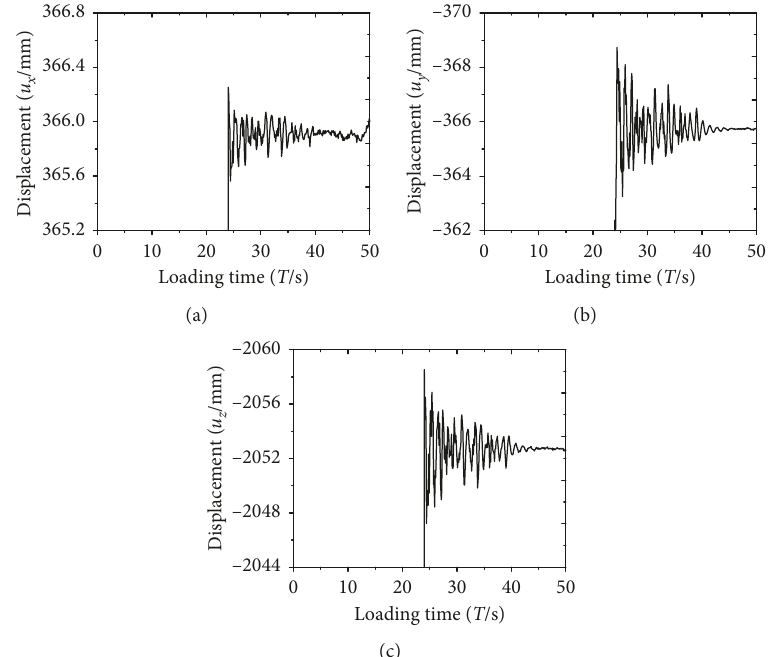
Figure 12: Variation of displacement with loading time.